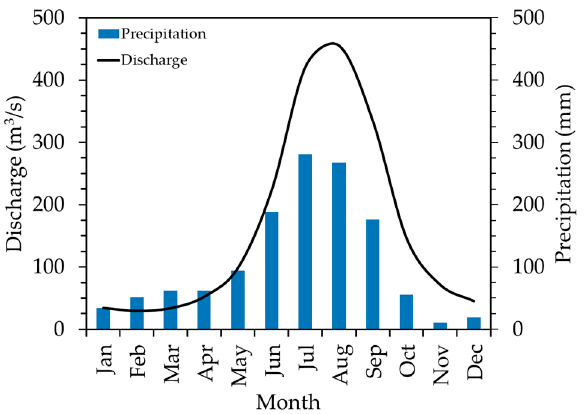
Figure 4. Long term rainfall-runoff pattern of the Budhigandaki River Basin at Arughat.